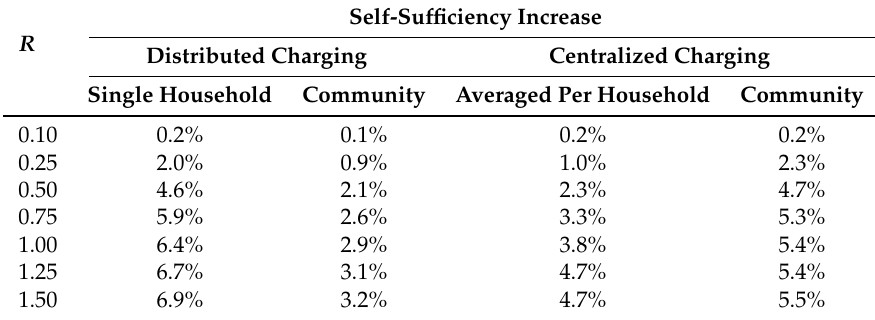
Table 2. Self-sufficiency improvements by smart charging schemes for a single household and on the community level with both distributed and centralized charging